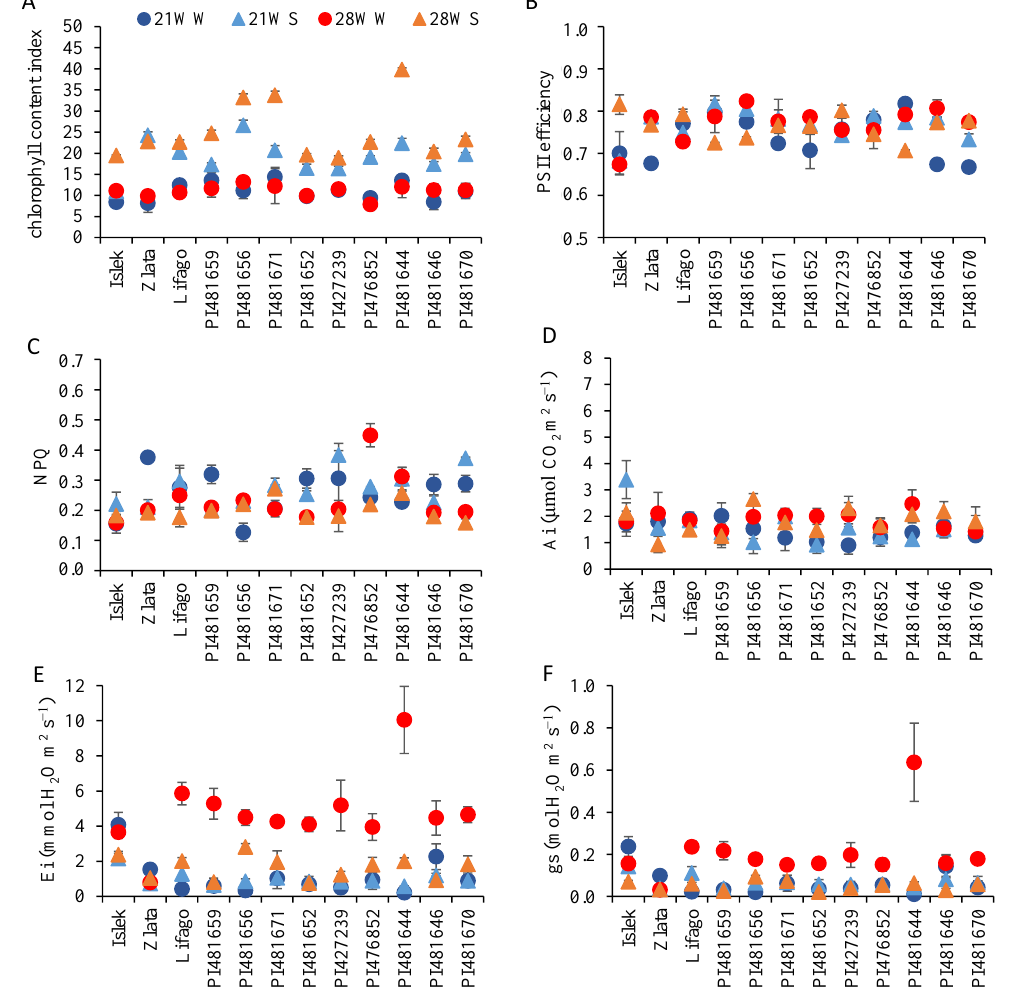
Figure 6. Photosynthesis and water status-related parameters of F. tataricum varieties subjected to two temperatures (21 °C vs. 28 °C) and water supply conditions (well-watered vs. water-stressed). ( A ) Chlorophyll content index, ( B ) photosystem 2 (PSII) efficiency, ( C ) non-photochemical quench- ing (NPQ), ( D ) net photosynthesis rate (Ai), ( E ) net transpiration rate (Ei), and ( F ) stomatal conduct- ance (gs) at 8 weeks after stress imposition. 21WW: 21 °C well-watered, 21WS: 21 °C water stress, 28WW: 28 °C well-watered, 28WS: 28 °C water stress. Regarding chlorophyll fluorescence parameters, the efficiency of photosystem 2